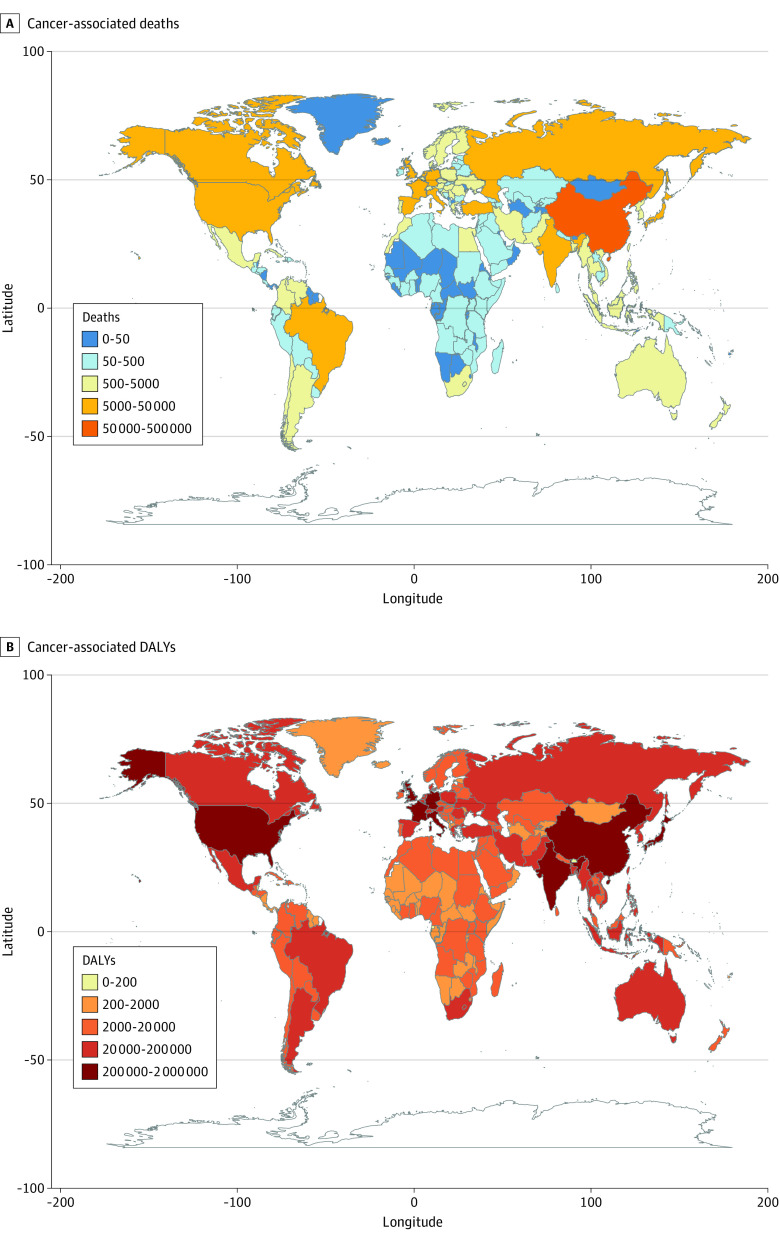
Number of Occupational Carcinogen–Attributable Cancer Deaths and Disability-Adjusted Life-Years (DALYs) for All Ages and Both Sexes in 195 Countries and Territories, 2017Cancer-associated deaths (A) and DALYs (B).